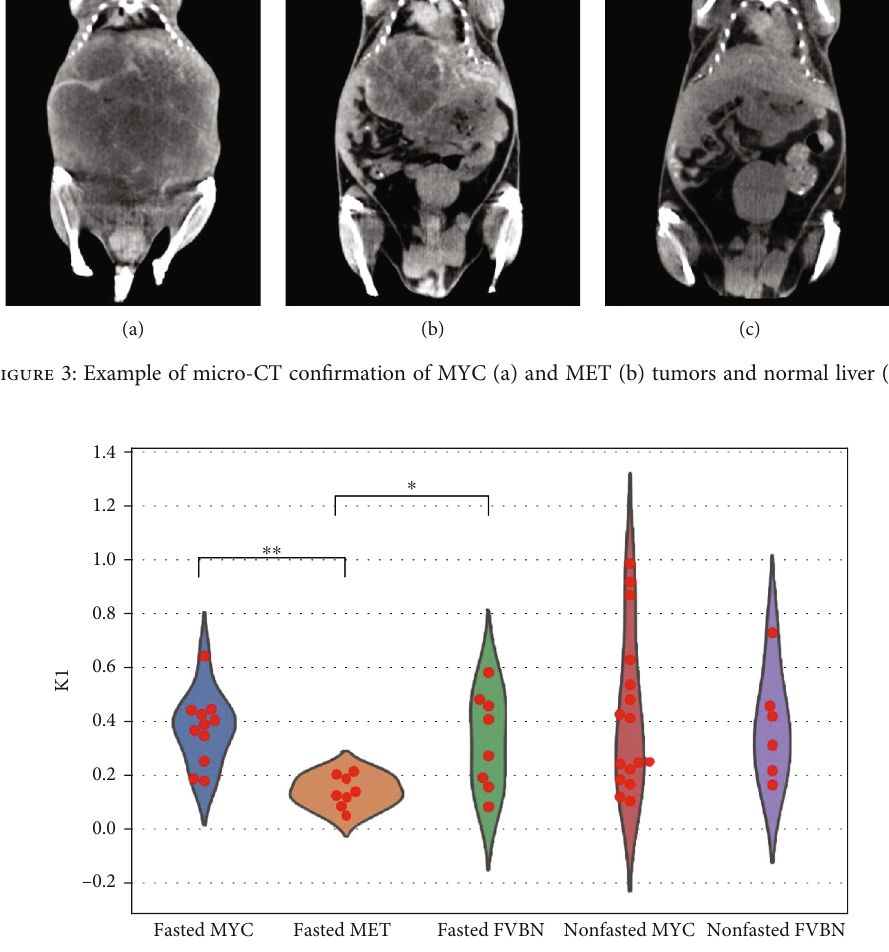
Figure 4: K 1 values computed using one-tissue compartment model for fasted and nonfasted MYC tumors ( respectively), fasted MET tumors ( n = 8 ), and fasted and nonfasted normal liver tissues ( n = 8 and n = 6 , respectively). ∗∗ P = 0 : 0002 between fasted MYC and fasted MET and ∗ P = 0 : 0123 between fasted MET tumors and fasted liver tissues. P = 0 : 5640 between fasted MYC and fasted normal liver, P = 0 : 7536 between nonfasted MYC and nonfasted normal liver, P = 0 : 5693 between fasted MYC and nonfasted MYC tumors, and P = 0 : 6039 between fasted and nonfasted normal liver